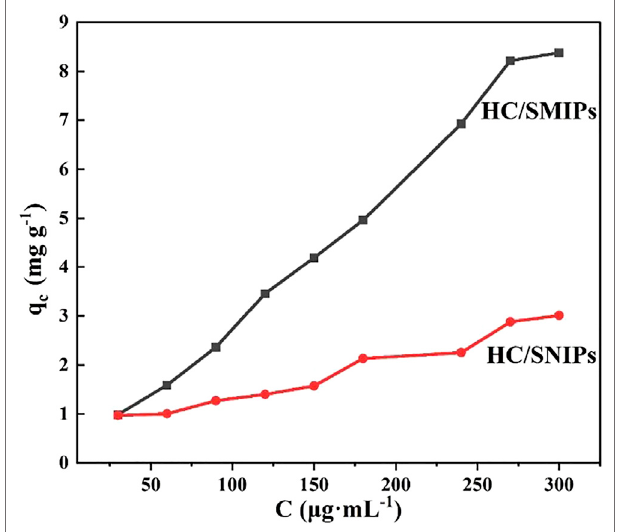
FIGURE 6 | Selective adsorption of HC/SMIPs and